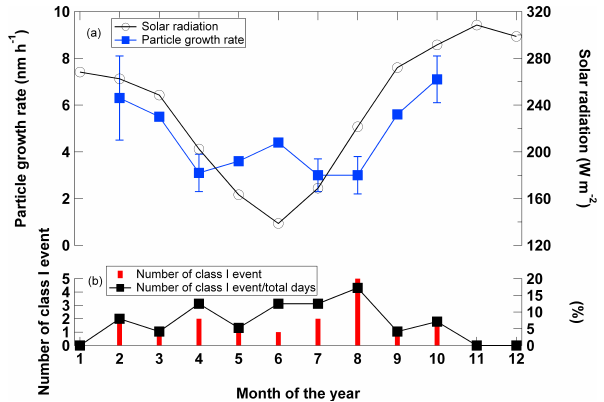
Fig. 9. Seasonal variation in (a) particle growth rates and solar ra- diation and (b) number of class I event and the precentage ratio of class I event to total sampling